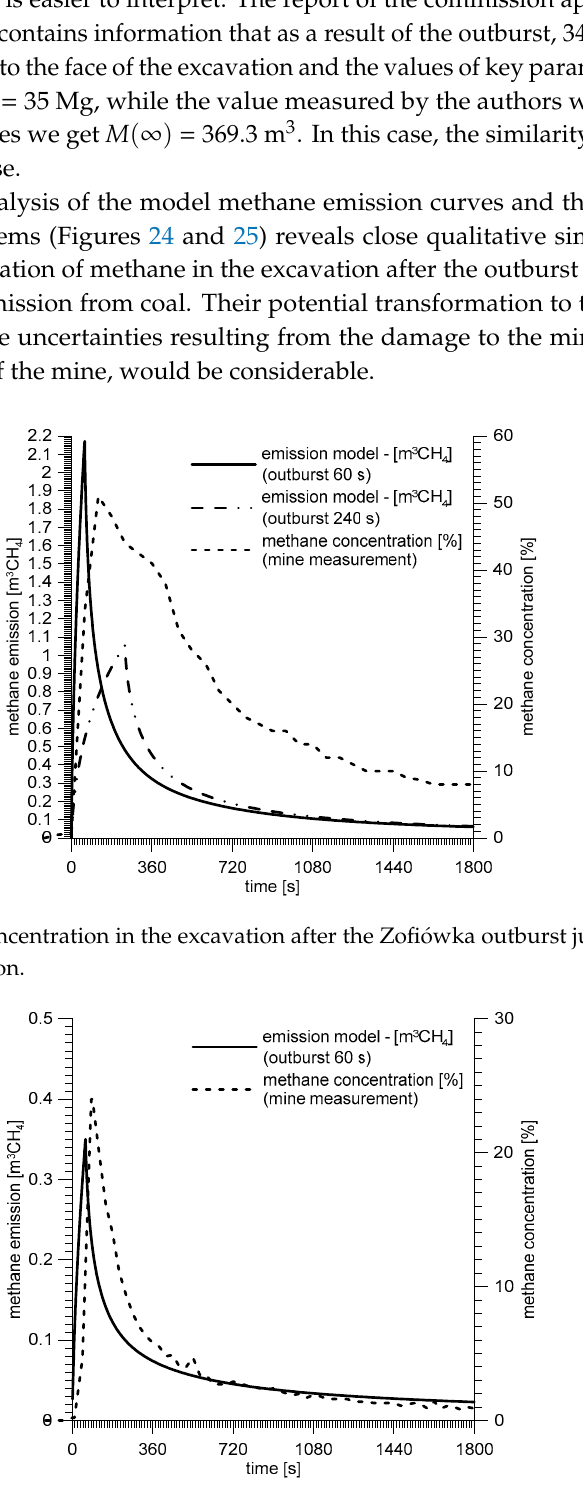
Figure 25. Methane concentration in the excavation after the Budryk outburst juxtaposed with the model methane emission. model methane